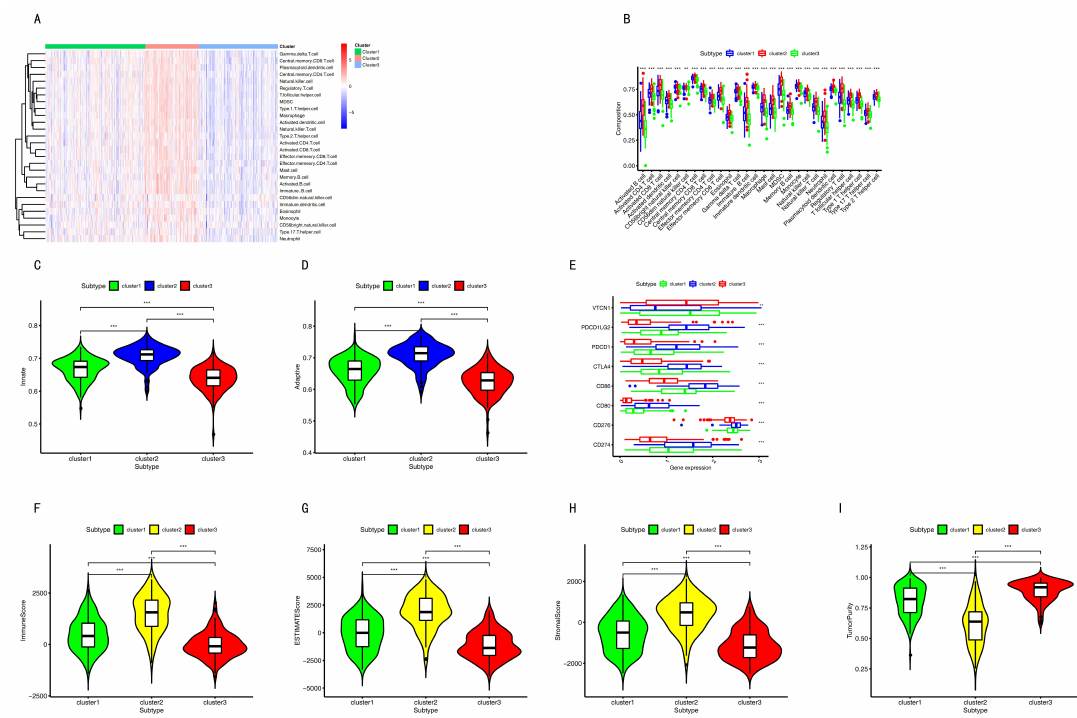
Figure 4. Immune status among the three subgroups. ( A ) Immune cell infiltration among the three subtypes. ( B ). Immune cells the among three subgroups. ( C , D ) Innate immune